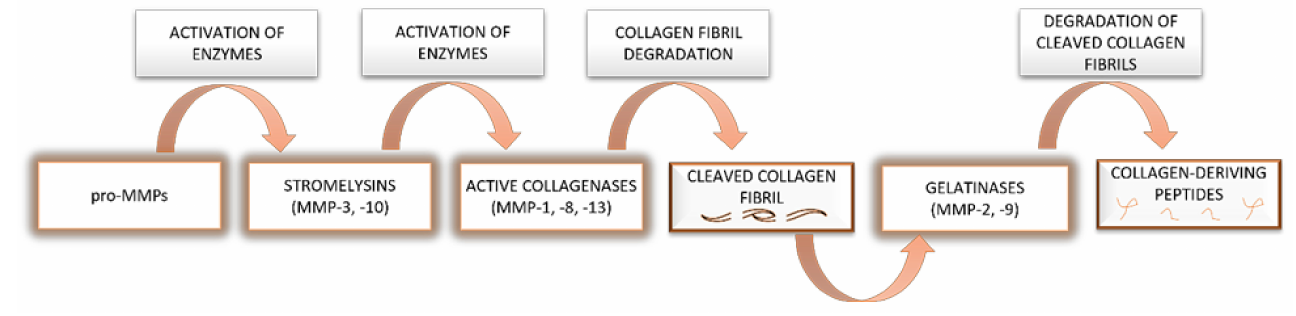
Figure 1. Collagen degradation pathway involving various MMPs